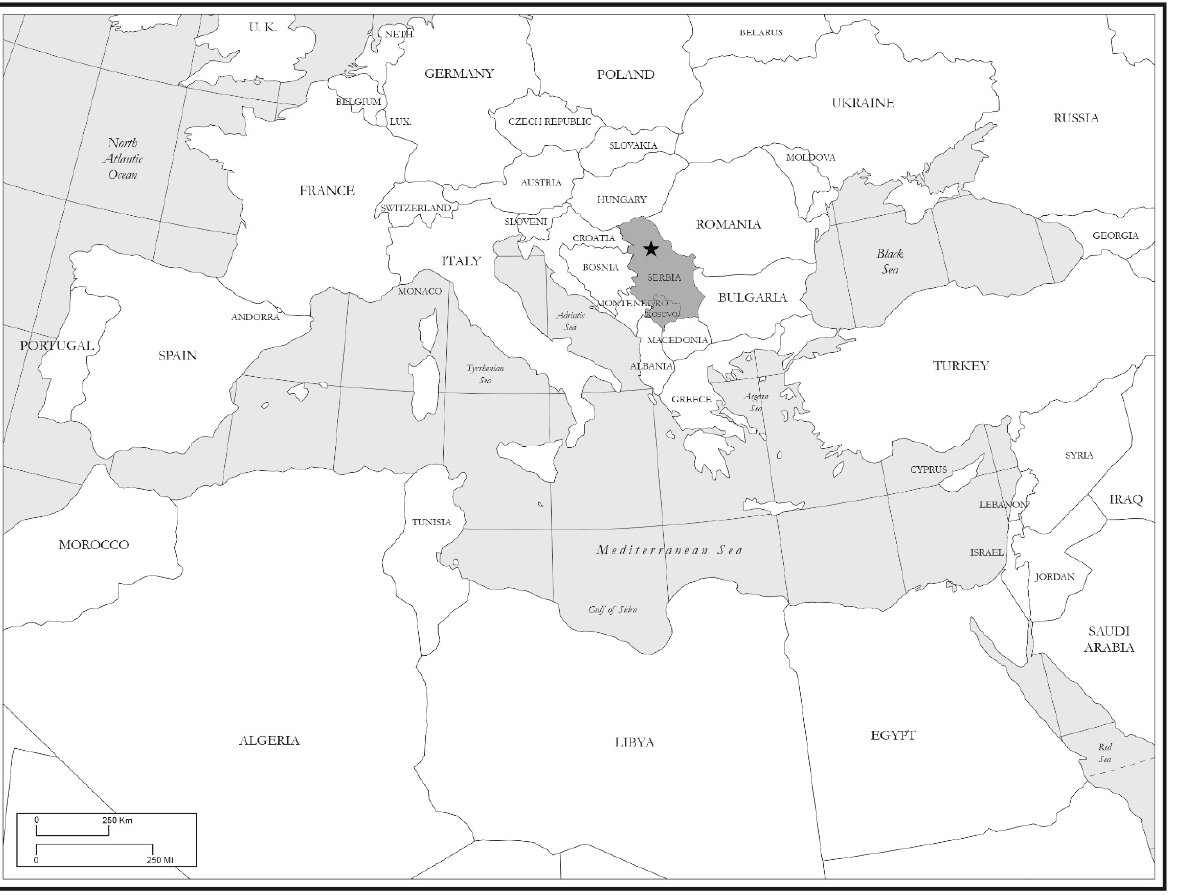
Figure 1. Location of Belgrade and the Republic of Serbia (Source: Alabama Maps n.d., adapted with permission from Remington C., published by The University of Alabama).